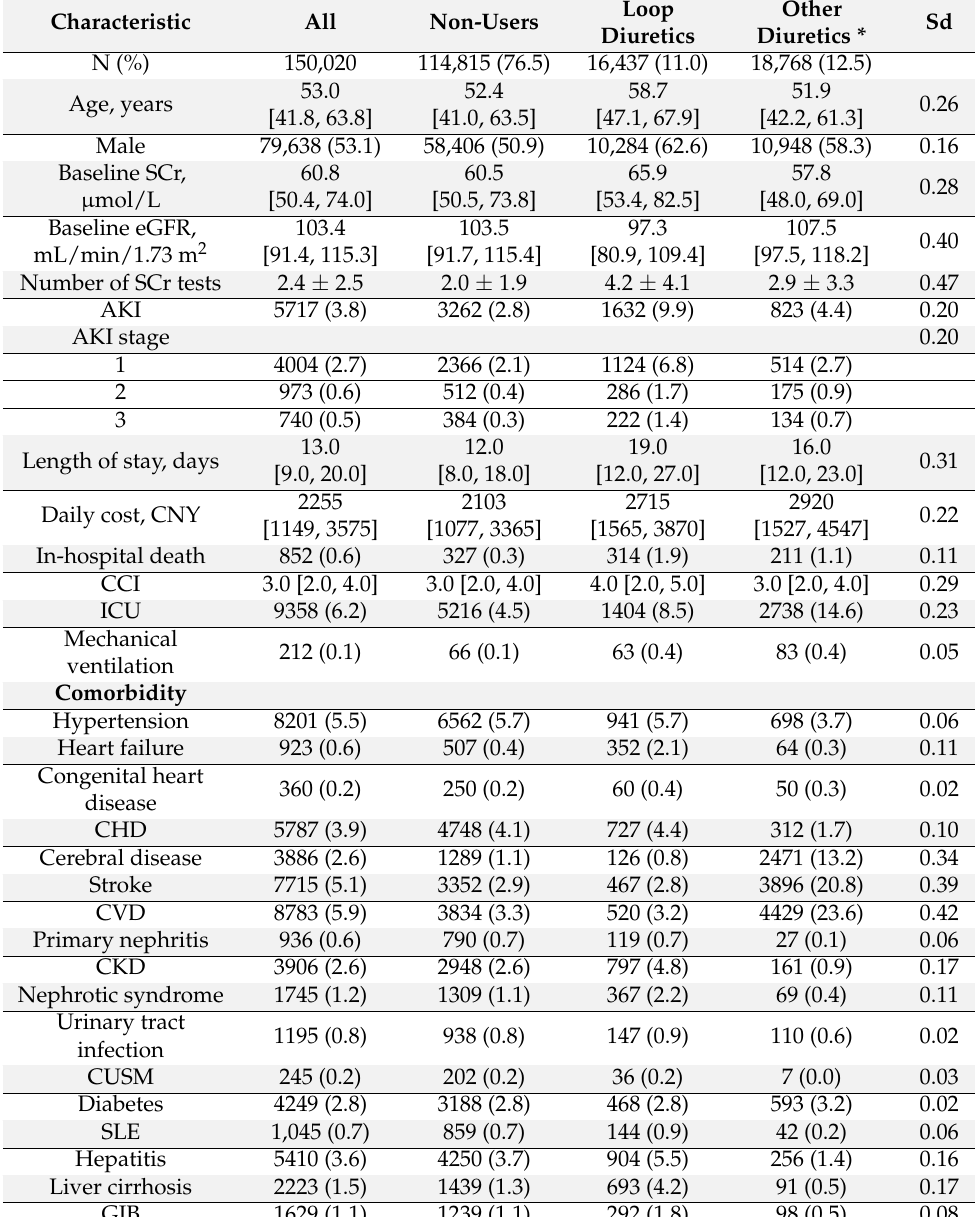
Table 1. Characteristics of hospitalized adults stratified by use of